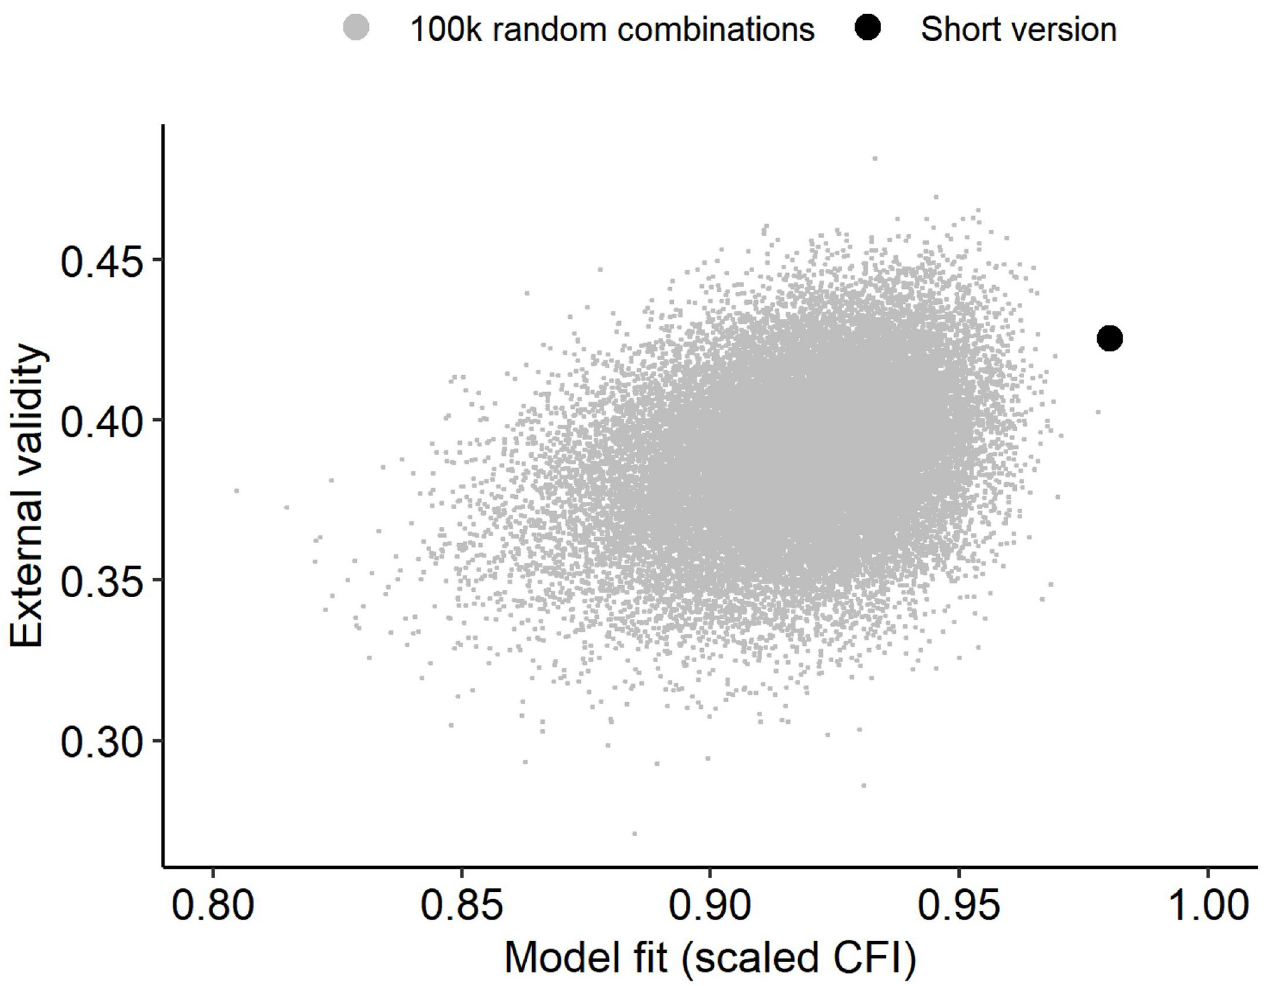
Fig 3. Fit and external validity of short version. Model fit and external validity of the optimized short version in comparison to 100,000 random item combinations.